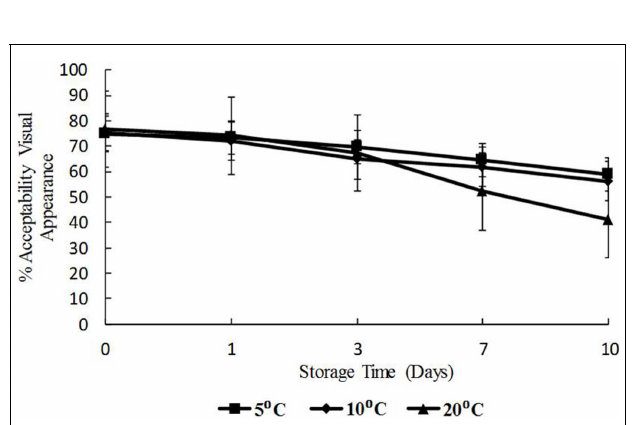
FIGURE 4 | Sensory evaluation of oysters under controlled conditions over a 10-day storage period at 5, 10, and 20°C, percent of panelists indicating yes, they would consume the oyster .